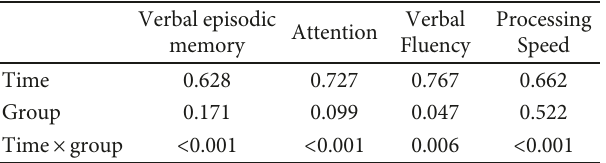
Table 6: Two-way mixed e ff ect ANOVA for cognitive domain performance: time (within subjects ’ factor) and patient group: (between subjects ’